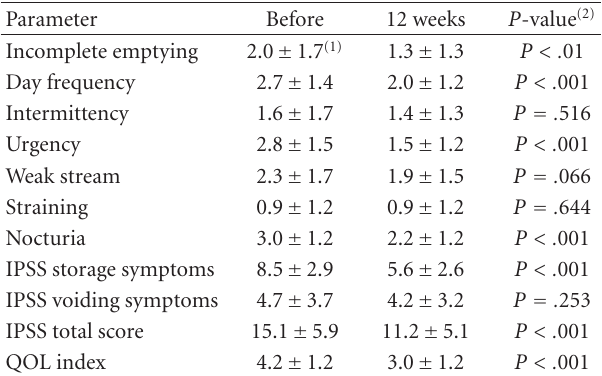
Table 1: Change in IPSS and QOL index before and after solifenacin treatment ( n =